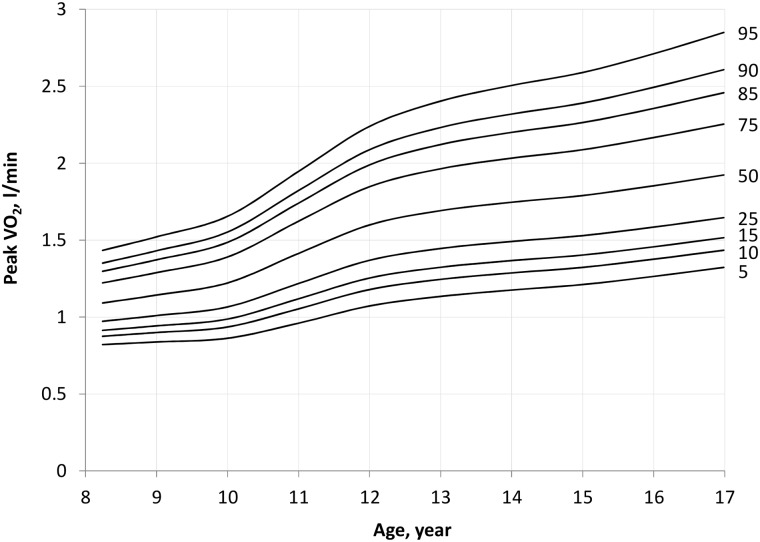
Percentile curves of peak VO2 (l·min-1) in girls.